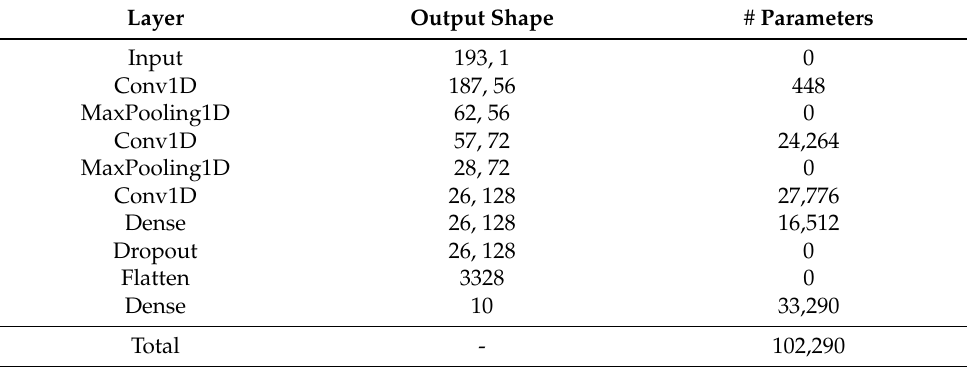
Table 1. Overview of our proposed 1D CNN model. It will be used as a reference when comparing to embedded